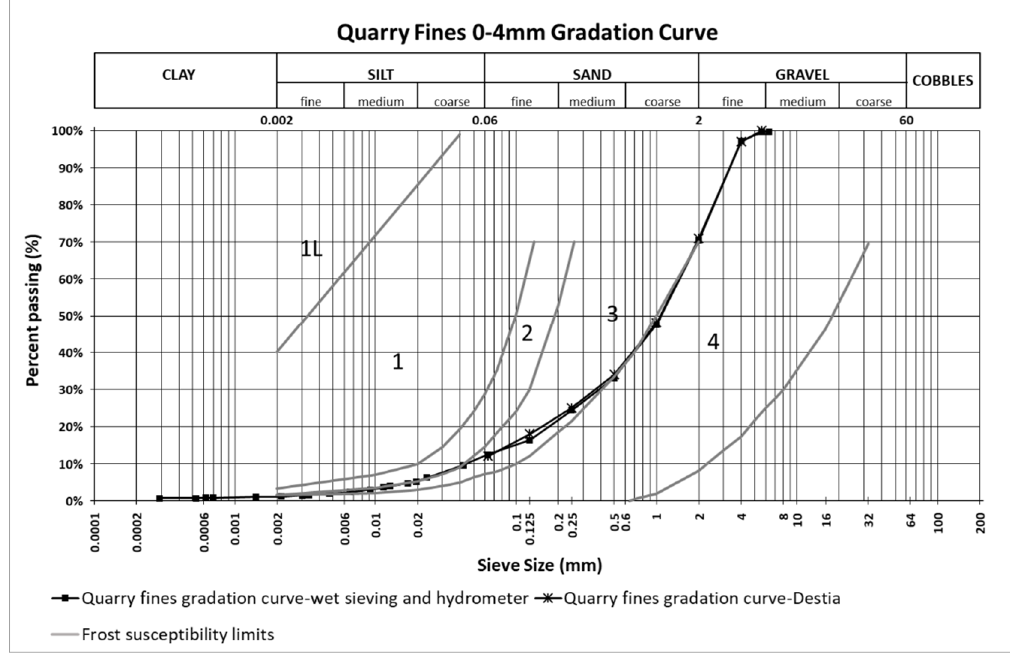
Figure 3. Estimation of frost susceptibility from the gradation curves of quarry fines according to ISSMGE [42]. Adapted with permission from [42]; 2005, Slunga, E., Saarelainen,